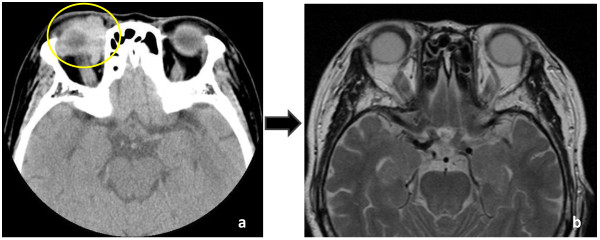
Patient presented with swelling and ptosis of the right upper eyelid. (a) Head CT of the orbit revealed abnormal high density area (yellow circle); (b) MRI revealed the presence of an infiltration of the right intraorbital diffuse mass which regressed and decreased in size one month after treatment was initiated.